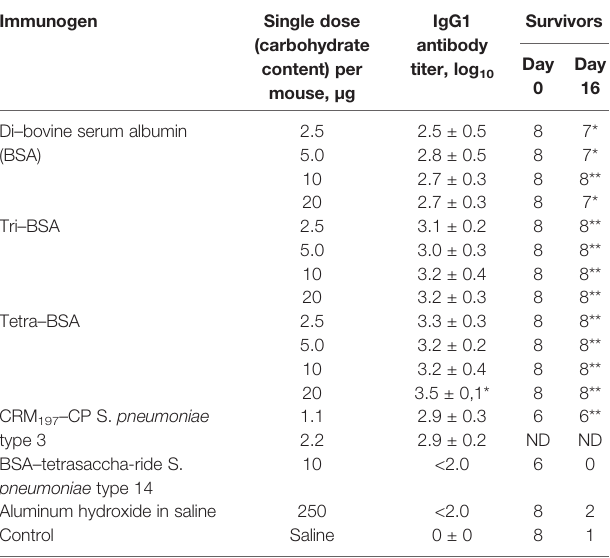
CP of S. pneumoniae type 3 as the well-coating antigen in ELISA. ND, not determined. Difference between immunized mice and non-immunized mice (control). Fisher exact test, *P < 0.05, **P <